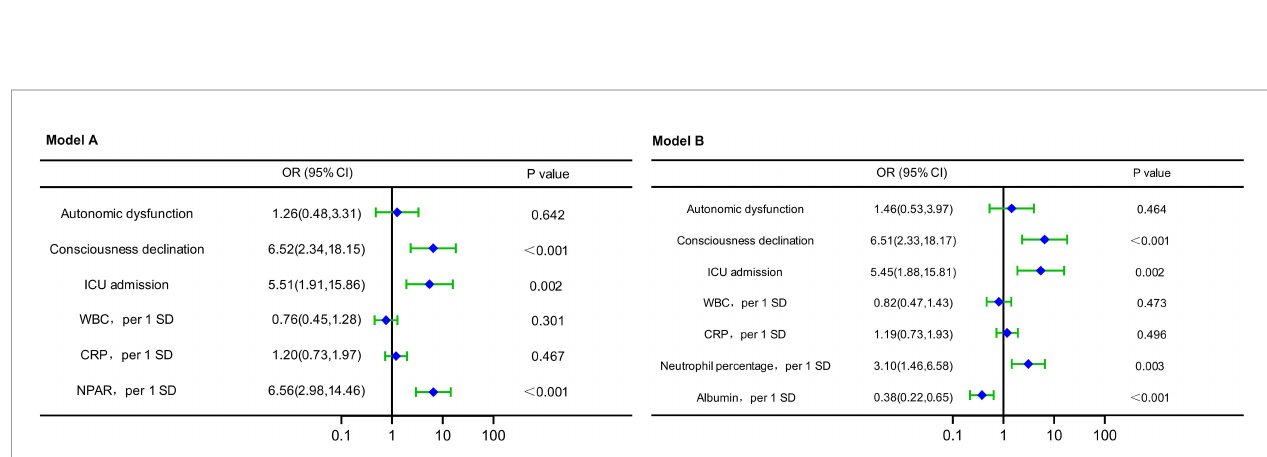
FIGURE 3 | Levels of neutrophil percentage, albumin, and NPAR in the mild-to-moderate and severe short-term prognosis groups.